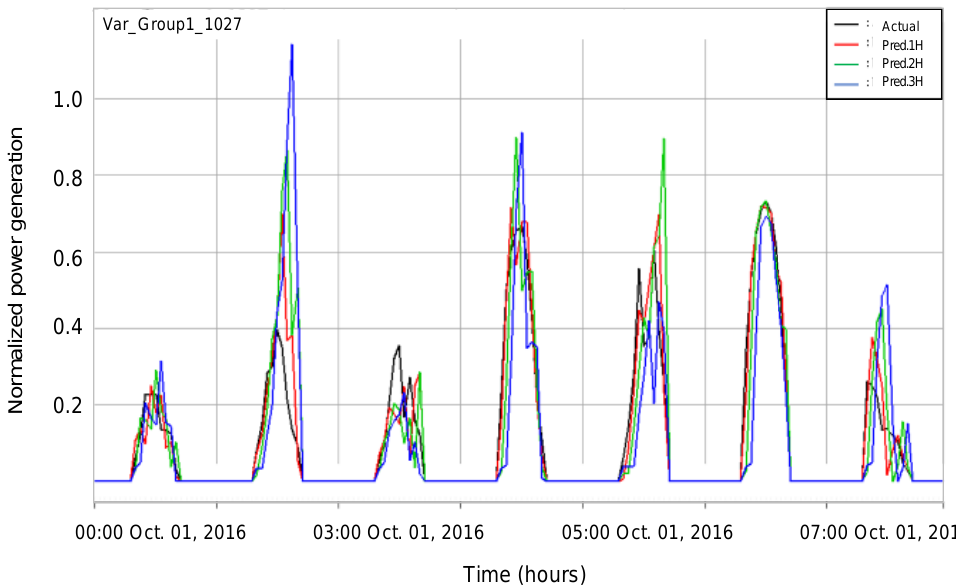
Figure 6. Time-series plot comparing values predicted using the VAR model from 00:00 on 1 October 2016, to 23:00 on 7 October 2016.